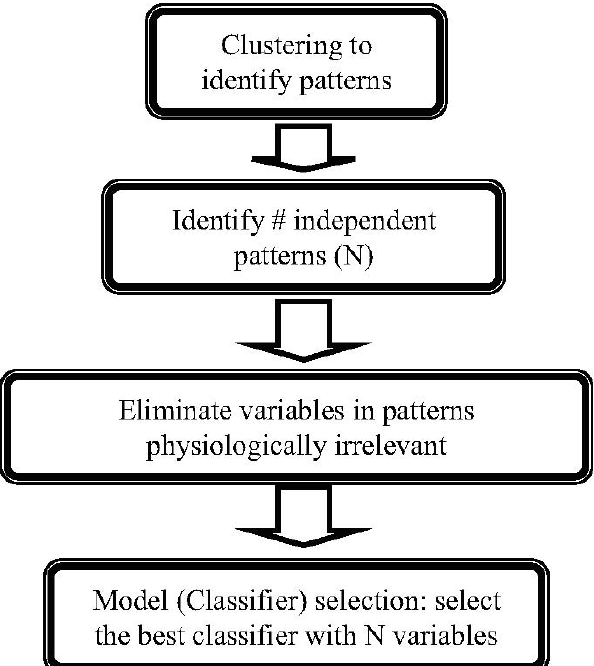
Figure 1. The burn-injury indicator identification